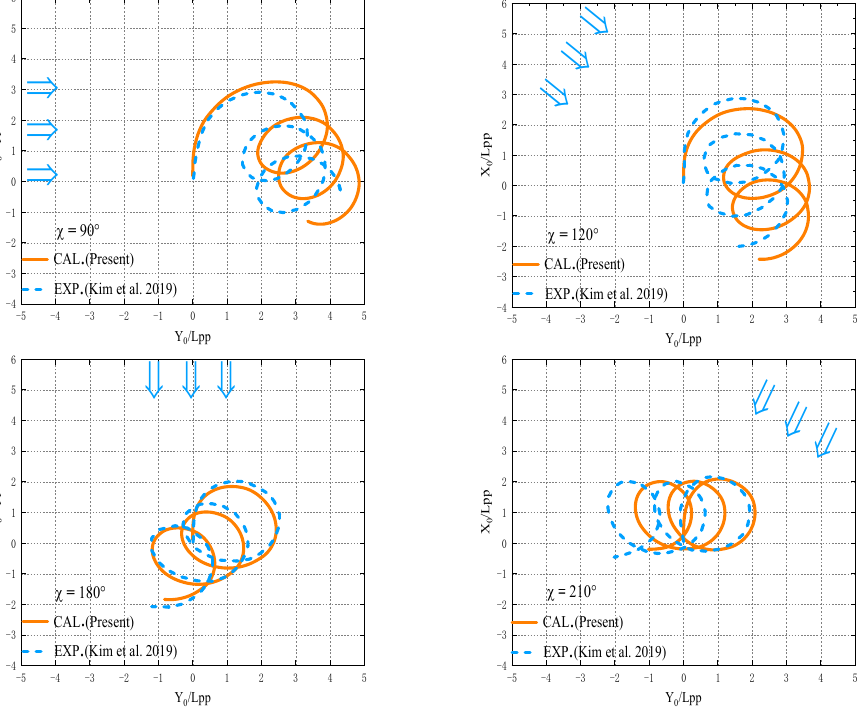
Figure 29. Comparisons of the turning trajectory of +35° turns with the variation of wave heading. The experimental values were reproduced from [8], with permission from Elsevier, 2022. Table 4. The advances and the tactical diameters of ships at different wave headings.